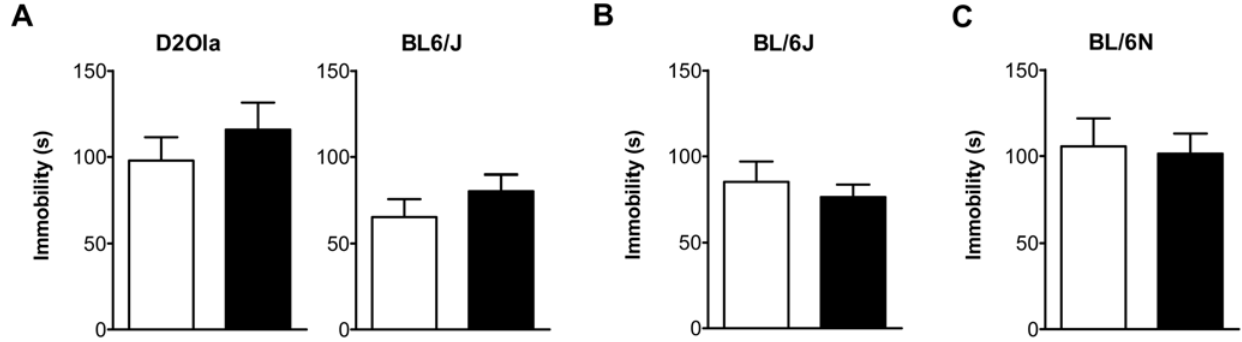
Figure 4. CMS effects on immobility in the FST. (A) 12 weeks of exposure to CMS had no effect on immobility time of D2Ola and BL/6J mice in the FST. (B) 4 weeks of CMS exposure had no effect on immobility time of BL/6J mice. (C) After 4 weeks of CMS exposure, BL/6N mice were subjected to the FST at the end of week 5. No changes in immobility time compared to the control group could be observed. Time of test: 8 A.M. (A,B) and 6 P.M. (C), respectively. Data represent mean + SEM, n=9–20/group. White bars: control group, black bars: CMS group.